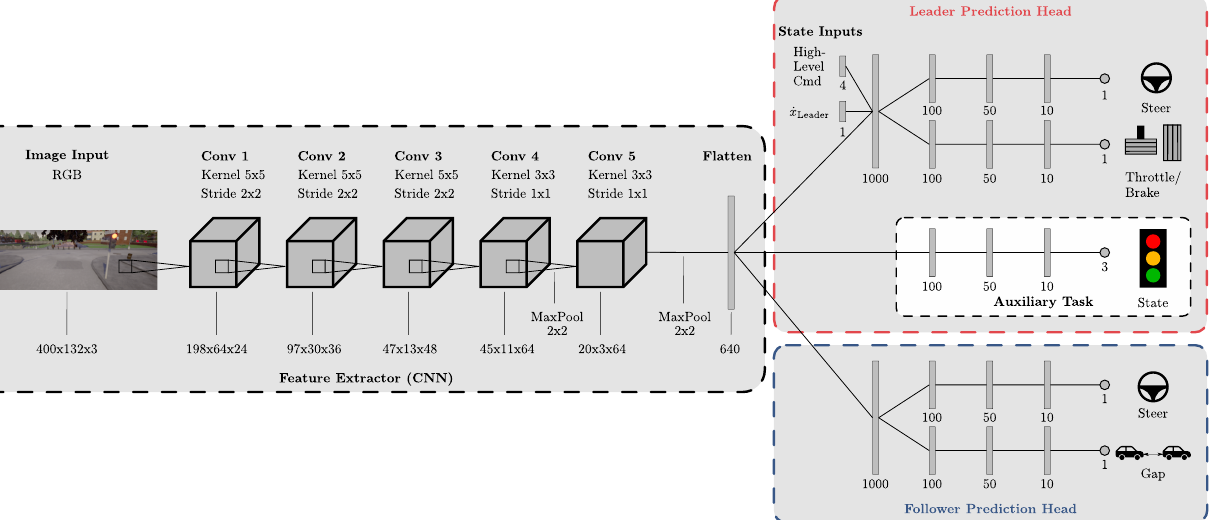
Figure 2. Detailed network architecture. The proposed multi-task deep learning network for connected and autonomous vehicle (CAV) platoons (Model A) with the details of the architecture. The feature extractor is a CNN based on PilotNet [25]. Following the feature extractor, the network consists of two prediction heads to serve its tasks in the leading and following vehicle, respectively. The prediction heads consist of FC networks with multiple branches for the individual